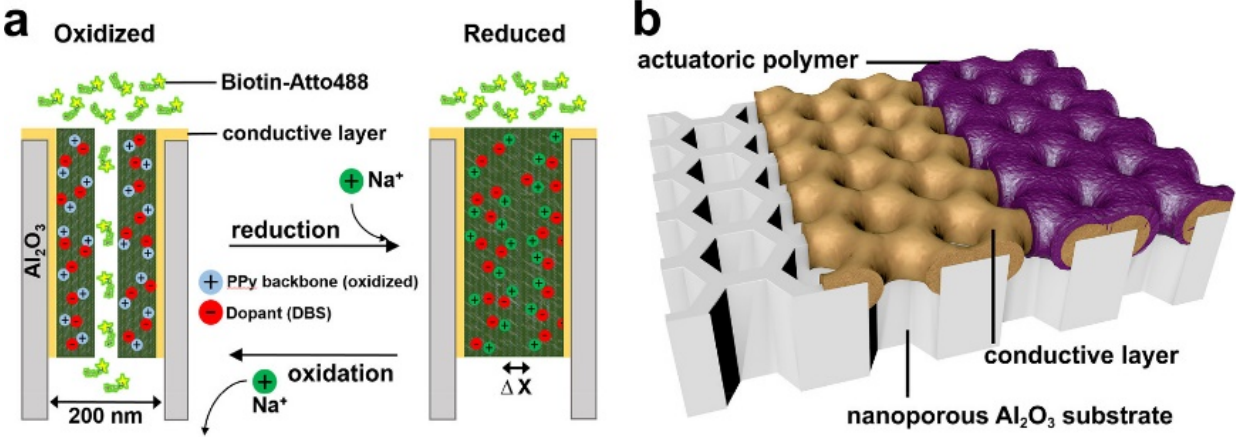
Figure 10. ( a ) Scheme of the electrochemical based opening and closing of the nanovalves, ( b ) Layer composition on the nanoporous aluminum oxide substrate [248]. Copyright 2018 Nano Letters.